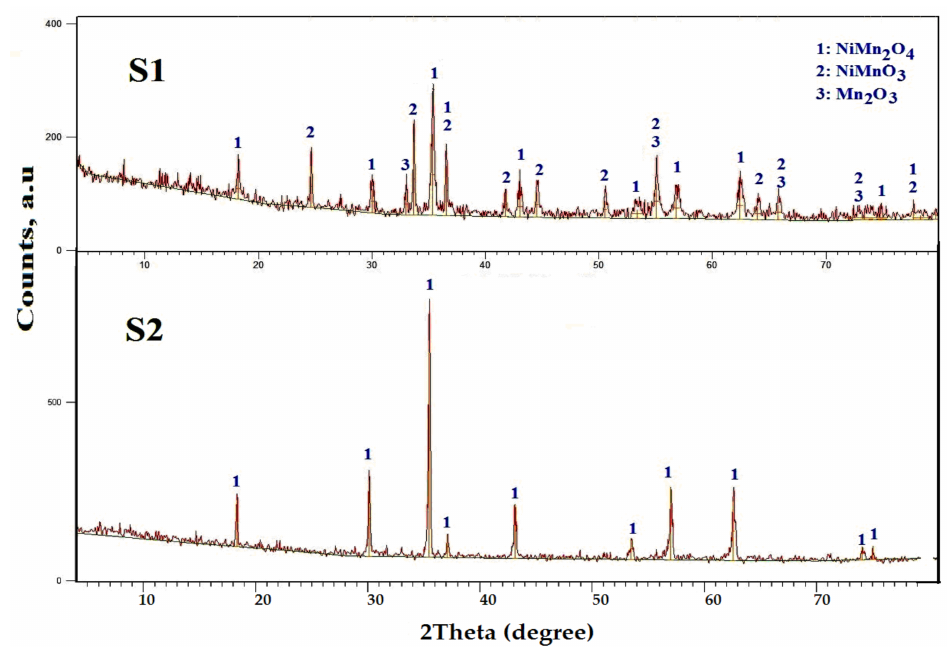
Figure 2. XRD patterns of the S1 and S2 samples.